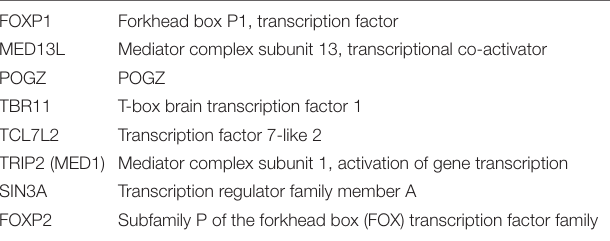
TABLE 5 | Transcription factors defective in some cases of